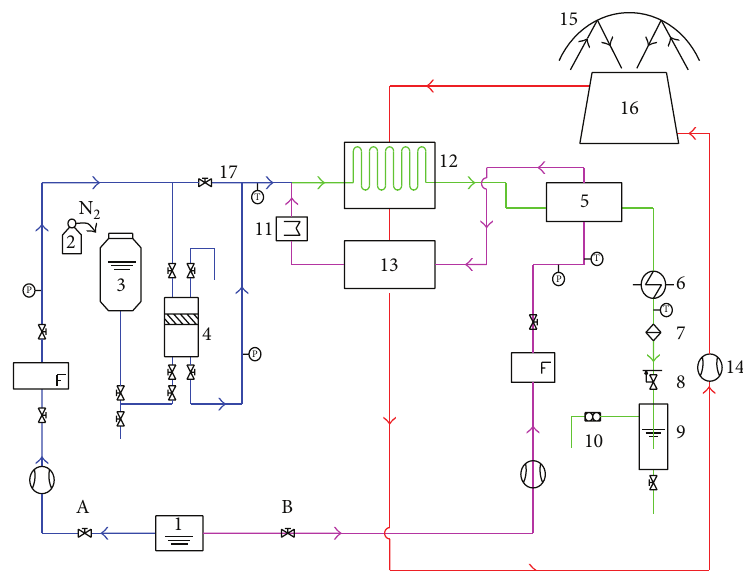
Figure 2: Hydrogen production system with preheating process (Method 2). (1) water tank, (2) nitrogen tank, (3) storage tank, (4) feeder, (5) regenerator, (6) cooler, (7) filter, (8) back pressure regulator, (9) gas-liquid separator, (10) wet gas flow meter, (11) electric heater, (12) high temperature molten salt heat tank, (13) low temperature molten salt heat tank, (14) pump for liquid salts, (15) optical block, (16) solar receiver, and (17) valve.